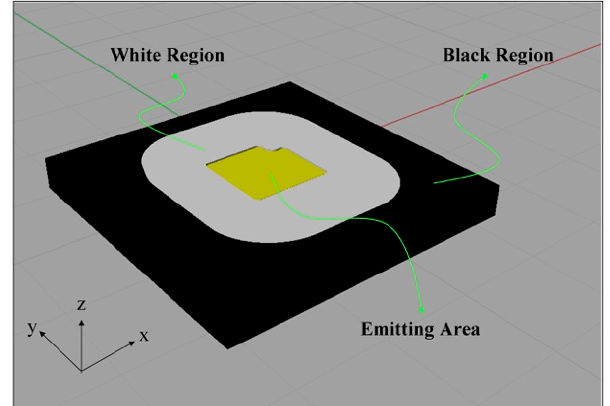
Figure 1. Geometry of Osram HWQP LED.